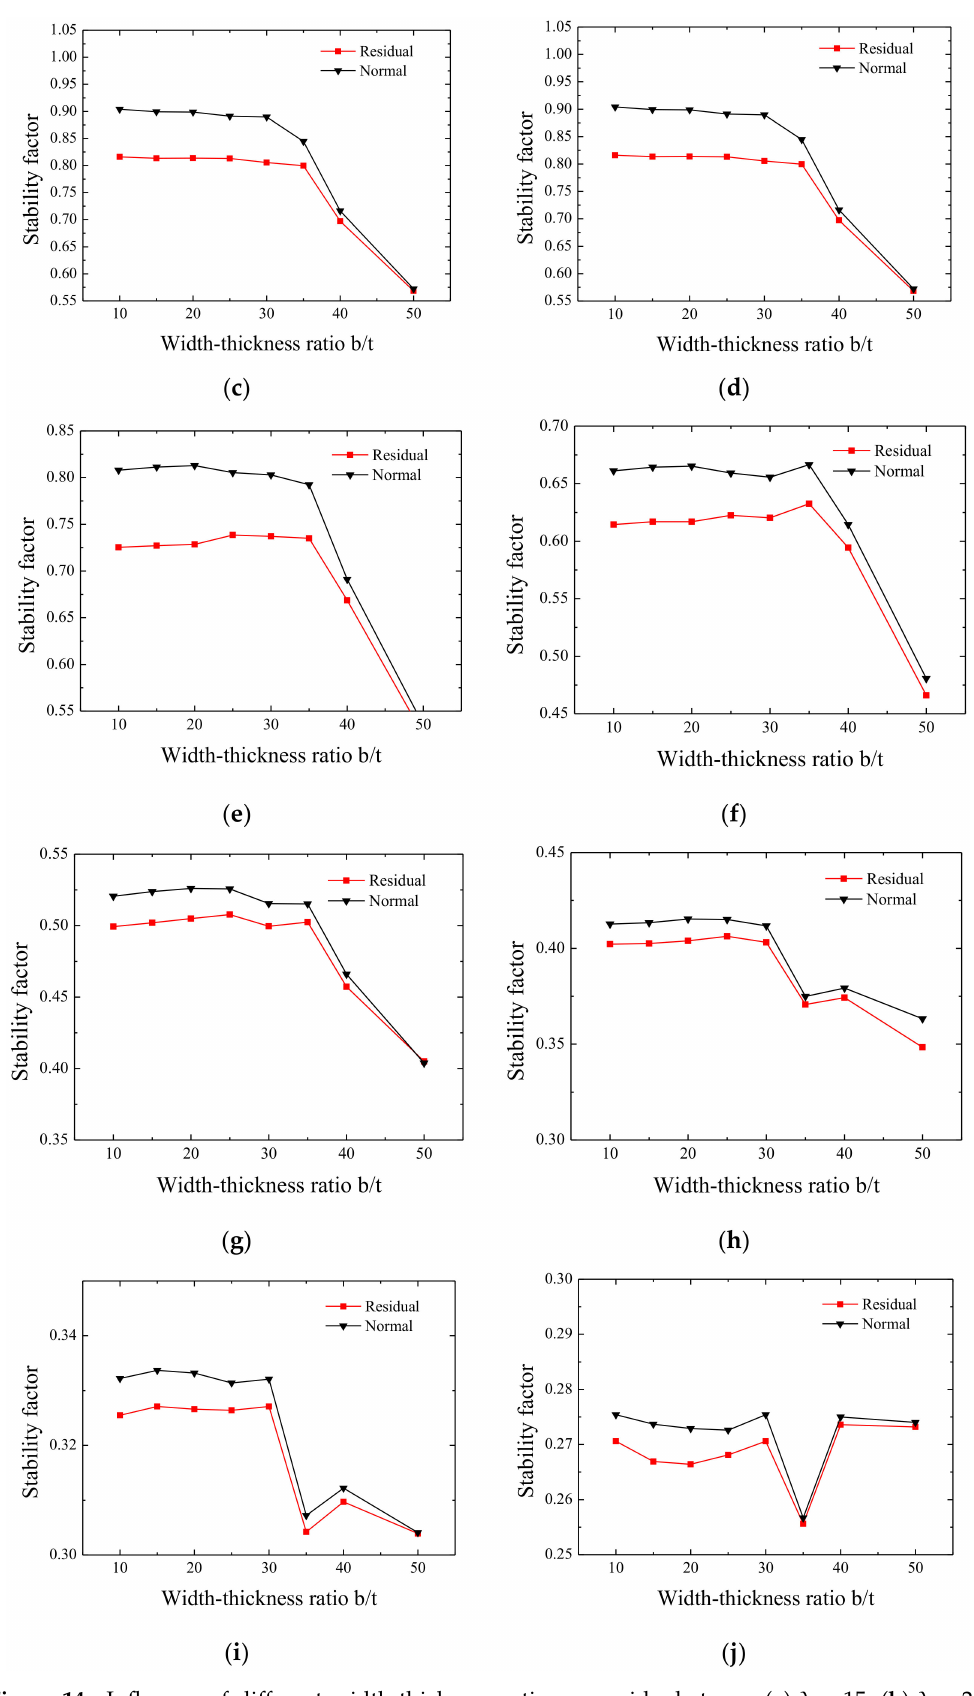
Figure 14. Influence of di ff erent width-thickness ratios on residual stress: ( a ) λ = 15, ( b ) λ = 20, ( c ) λ = 30, ( d ) λ = 40, ( e ) λ = 50, ( f ) λ = 60, ( g ) λ = 70, ( h ) λ = 80, ( i ) λ = 90, and ( j ) λ =